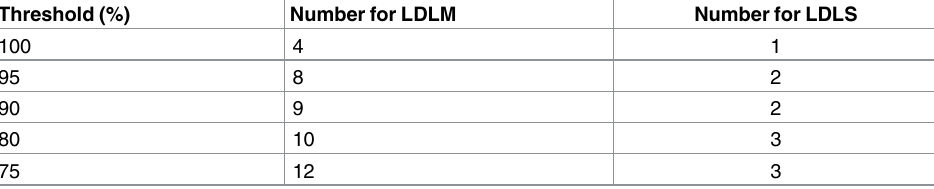
Table 6. Number of original stable covariables for the strategies LDLM and LDLS.